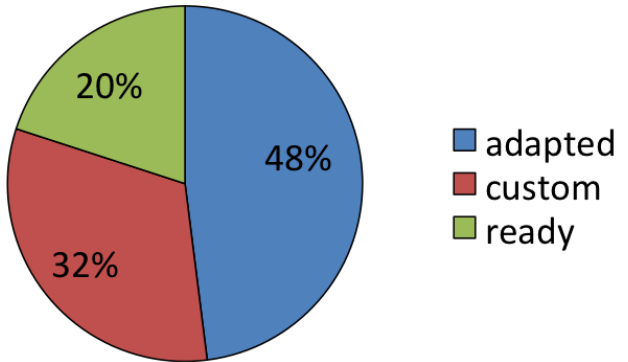
Figure 5. Custom, adapted and off-the-shelf mote usage in deployments —Almost half of deployments adapt off-the-shelf motes by custom sensing and packaging hardware, 32% use custom platforms and only 20% use commercial motes with default sensing modules.